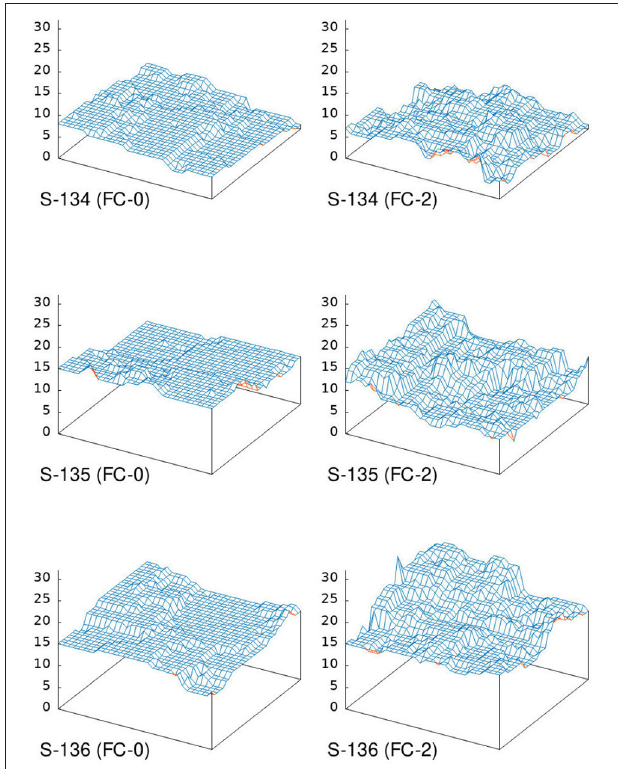
FIGURE 8 | Log-log plot showing average roughness, W , as a function of system size, L , for a large number of fractured samples of each size. Disorder magnitude is D = 1.5. (FC-0) denotes the result obtained with the “original” fracture criterion, Equation (22). Black dots indicate those values to which the straight line has been fit using linear